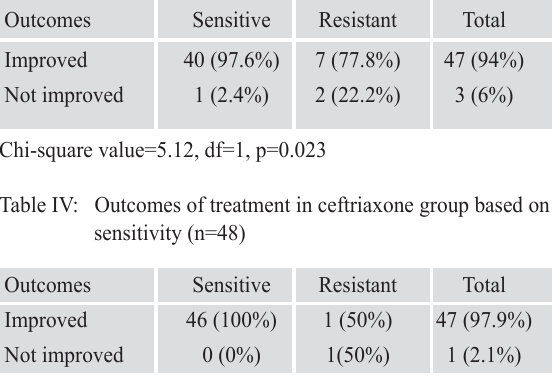
Table V: Comparison of treatment outcomes between azithromycin and ceftriaxone groups